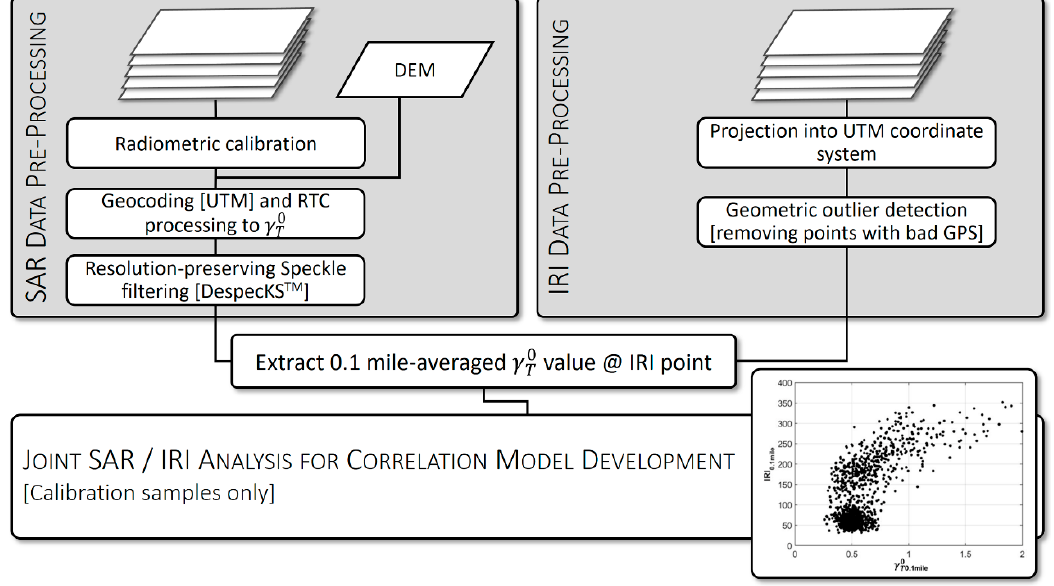
Figure 4. Workflow for IRI vs. radar brightness forward model development.